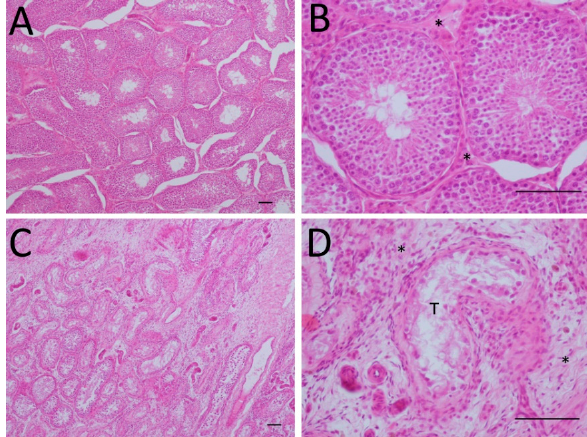
Figure 4. Histological alterations in the testicular parenchyma due to vaccination. One month after the end of the study (day 210), 25 animals were surgically castrated for testicular parenchyma evaluation. Of these, 20 dogs presented “normal” testicular parenchyma with seminiferous tubules with normal structure and spermatocyte maturation ( A ) and an interstitium with few cells and scarce amount of connective tissue (asterisks) ( B ). Five dogs presented testicular degeneration or atrophy characterized by remaining seminiferous tubules having an irregular profile and separated by connective tissue ( C ) and seminiferous tubules with loss of most maturation layers and thickened basement membrane with an irregular profile. Interstitium is expanded by fibrosis and few inflammatory cells (asterisks) ( D ). Five-micrometer slices were stained with hematoxylin–eosin to analyze testicular parenchyma. A and C: Bar 200 µ m; B and D: Bar 100 µ